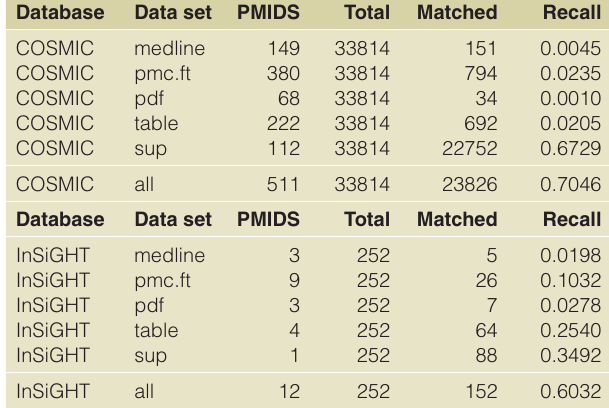
Table 15. COSMIC and InSiGHT variant extraction coverage combining OMM, SETH and EMU. The data sets considered are